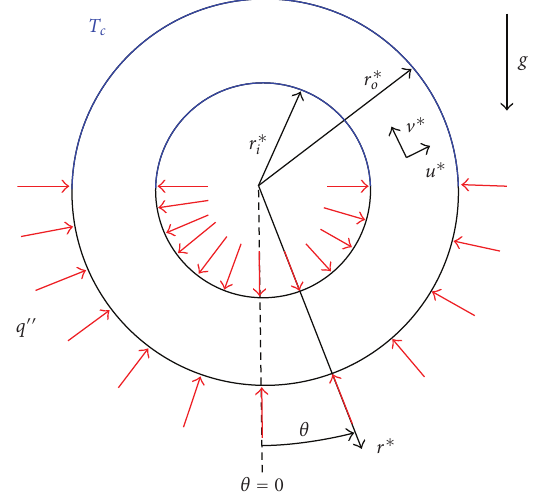
Figure 1: Coordinates and 2D-annular